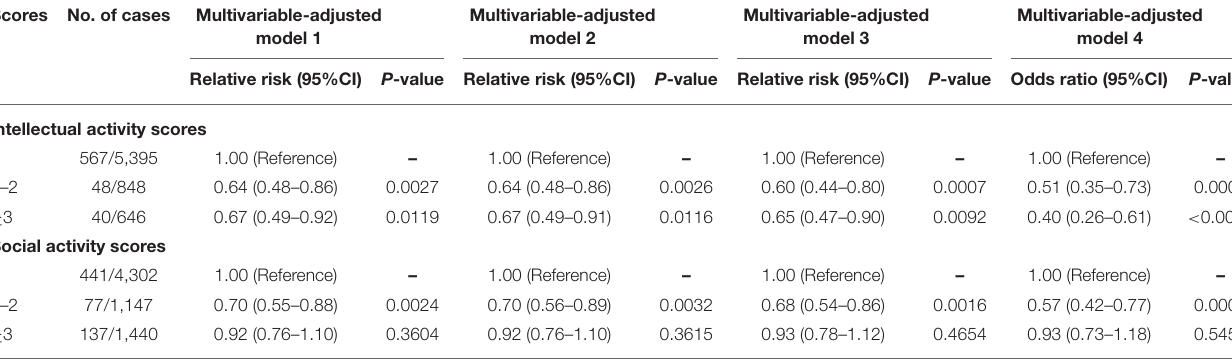
TABLE 2 | Risk of frailty according to the intellectual activity and social activity scores. Scores No. of